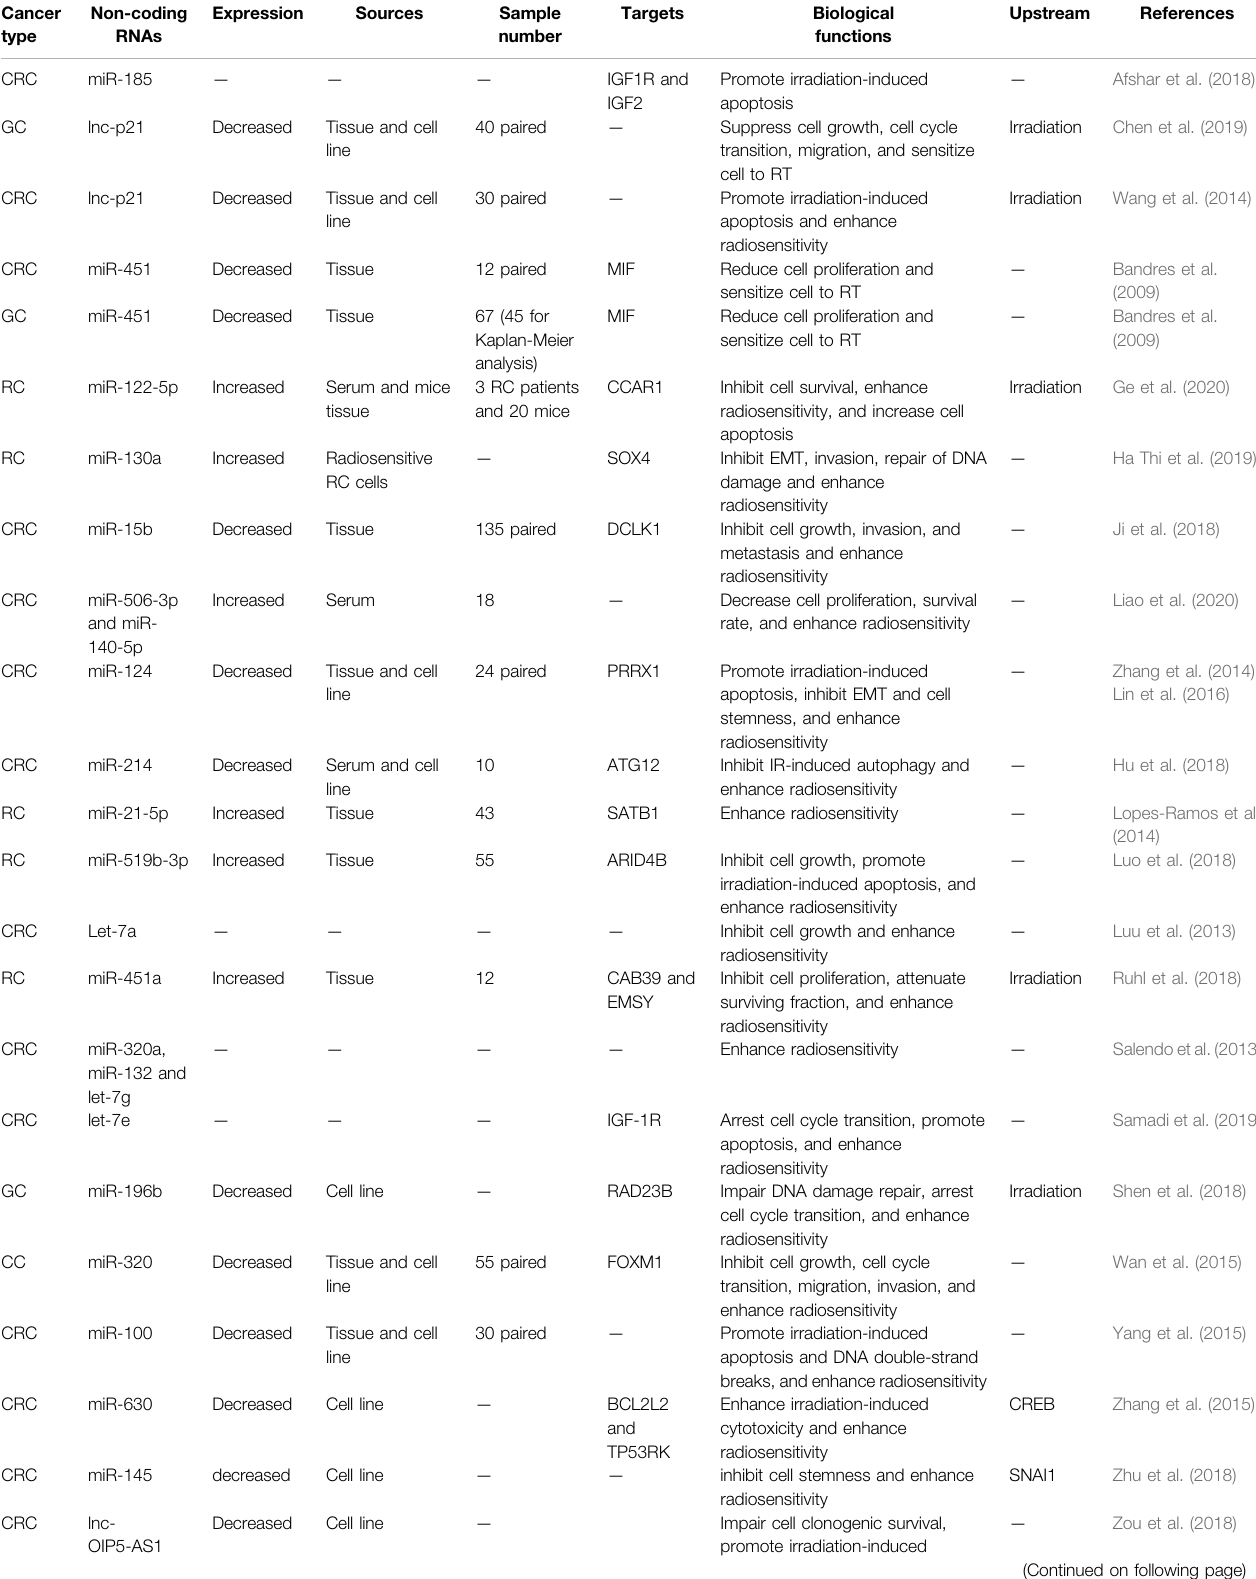
TABLE 1 | The radiosensitivity enhancement of non-coding RNAs in gastrointestinal